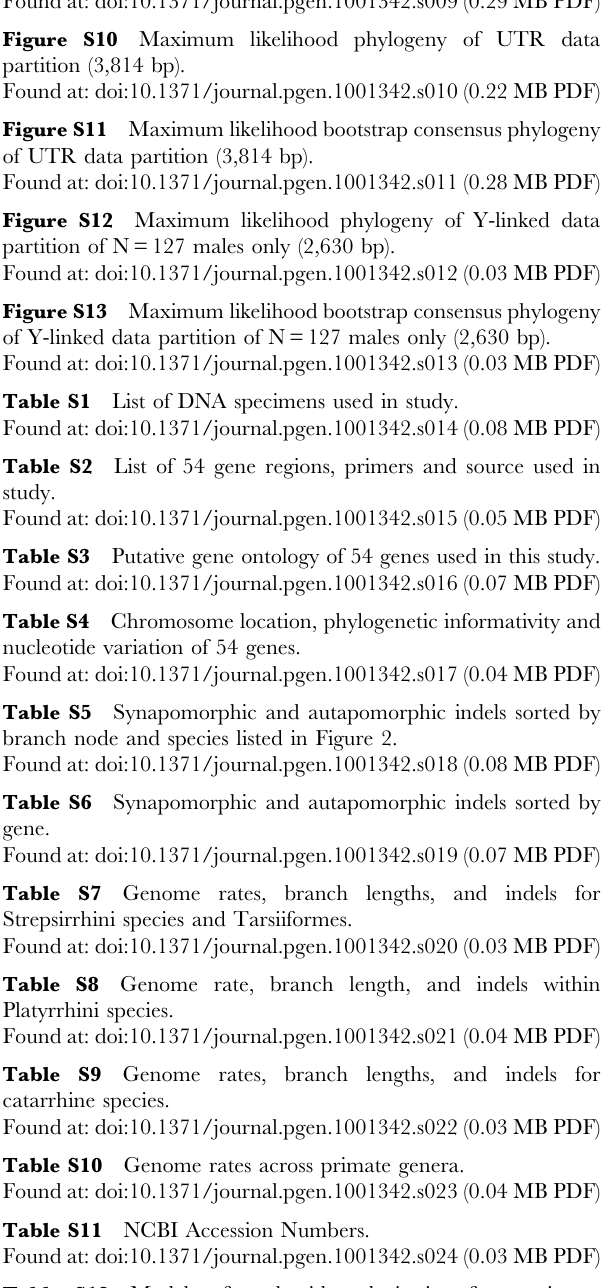
Figure S1 Large tabloid format of Figure 2 from main text. Found at: doi:10.1371/journal.pgen.1001342.s001 (1.23 MB PDF) Figure S2 Maximum likelihood phylogeny of autosome data partition (27,427 bp). Figure S3 Maximum likelihood bootstrap consensus phylogeny of autosome data partition (27,427 bp). Found at: doi:10.1371/journal.pgen.1001342.s003 (0.28 MB PDF) Figure S4 Maximum likelihood phylogeny of X-linked data partition (4,870 bp). Found at: doi:10.1371/journal.pgen.1001342.s004 (0.22 MB PDF) Figure S5 Maximum likelihood bootstrap consensus phylogeny of X-linked data partition (4,870 bp). Found at: doi:10.1371/journal.pgen.1001342.s005 (0.29 MB PDF) Figure S6 Maximum likelihood phylogeny of intron data partition (16,371 bp). Found at: doi:10.1371/journal.pgen.1001342.s006 (0.22 MB PDF) Figure S7 Maximum likelihood bootstrap consensus phylogeny of intron data partition (16,371 bp). Found at: doi:10.1371/journal.pgen.1001342.s007 (0.29 MB PDF) Figure S8 Maximum likelihood phylogeny of exon data partition (14,742 bp). Found at: doi:10.1371/journal.pgen.1001342.s008 (0.22 MB PDF)